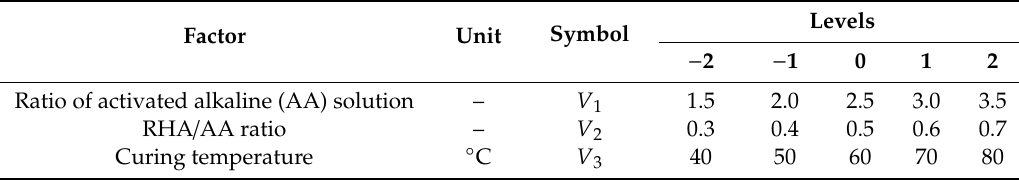
Table 2. Factors and levels used for the flexural